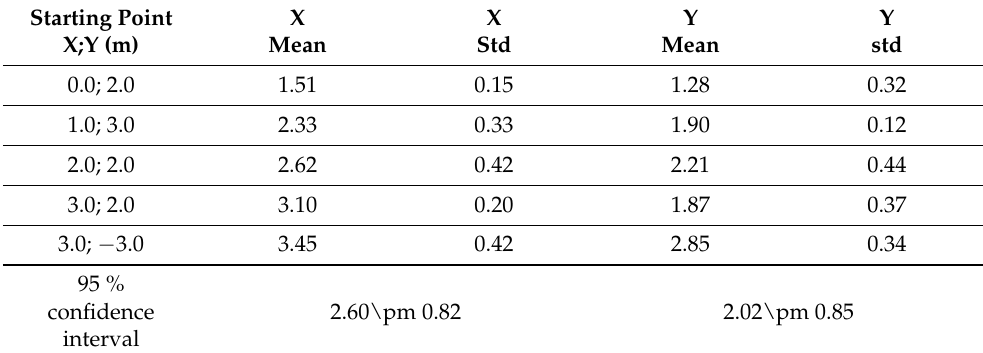
Table 1. Mean and standard deviation for X and Y tag measurements.